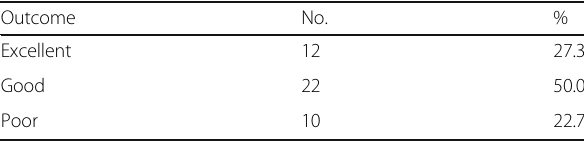
Table 3 The surgical